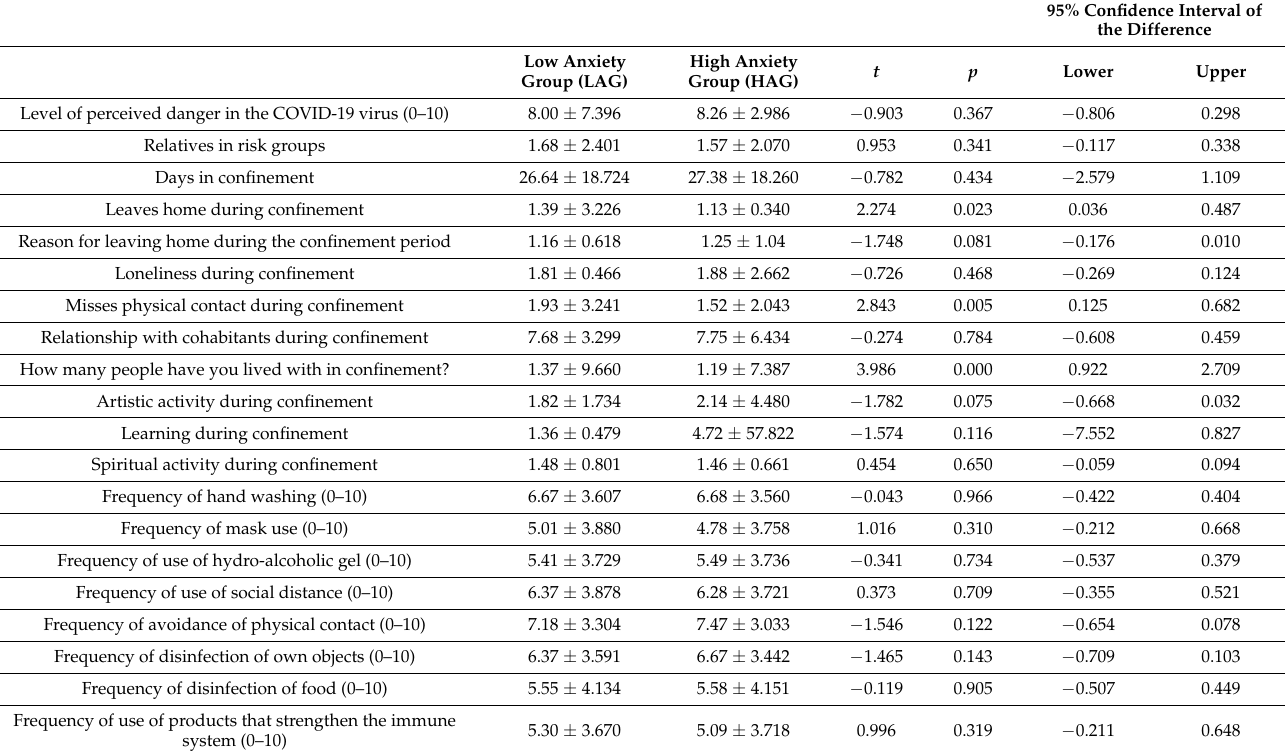
Table 5. Differences between groups in COVID-19-related